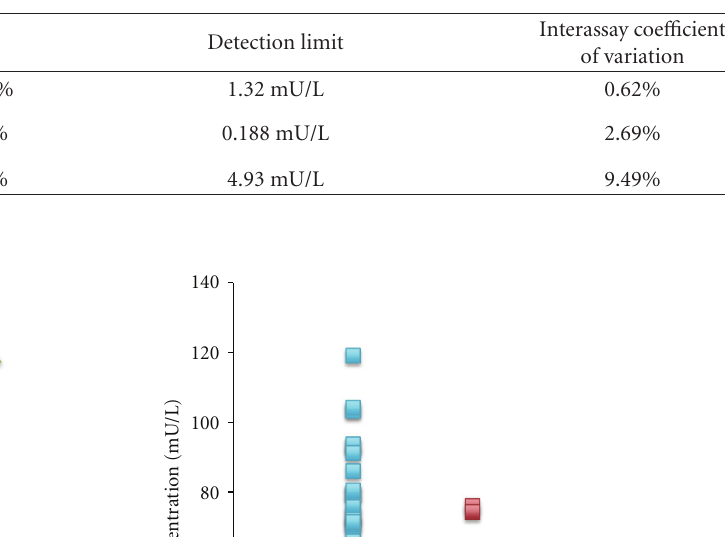
Table 2: Insulin assay verification.